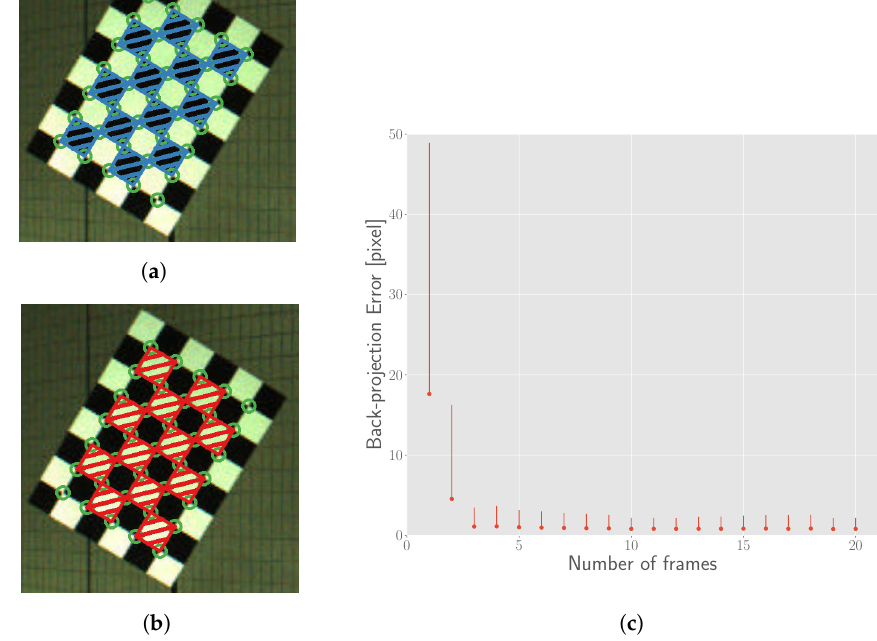
Figure 17. Re-projection error calculation and results. ( a , b ) Shaded quadrilaterals show the regions of black and white patterns respectively. Points mapped into these regions are counted for error calculation; ( c ) The errors for parameters estimated by different numbers of frames. The point and vertical line represent the mean and 3 σ range of all errors calculated by applying the estimated parameters to the different number of